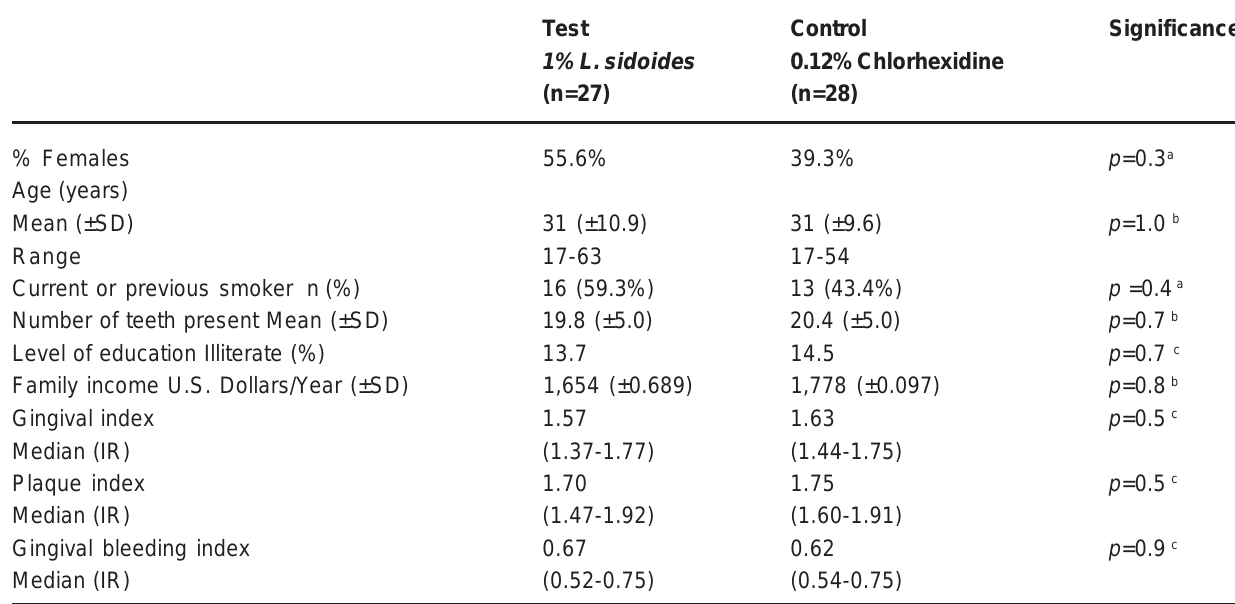
SD = standard deviation; IR = interquartile range; a Fisher’s exact test; b Student’s t-test; c Mann-Whitney